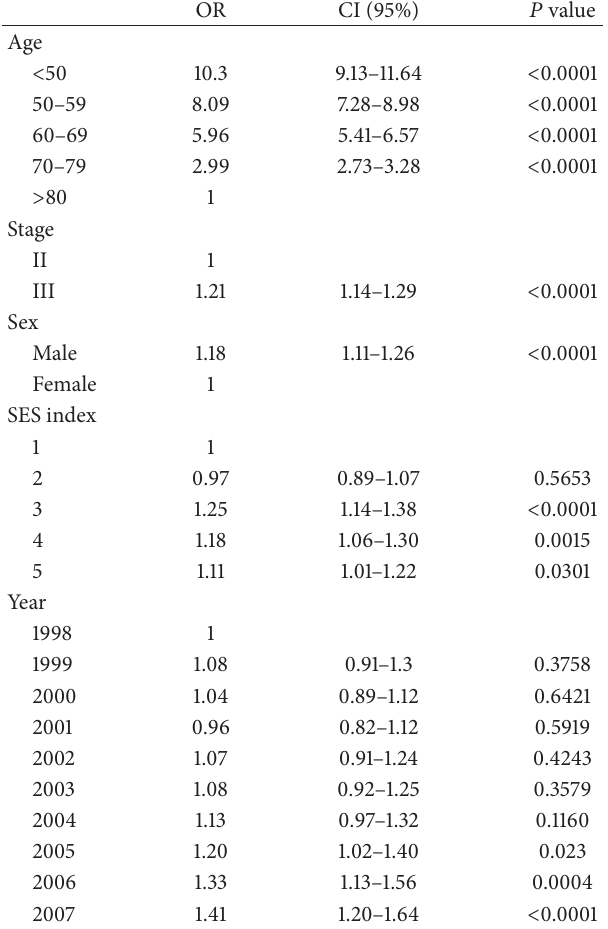
Table 2: Logistic regression of factors associated with radiation delivery in rectal cancer patients undergoing surgery, SEER17 1998–